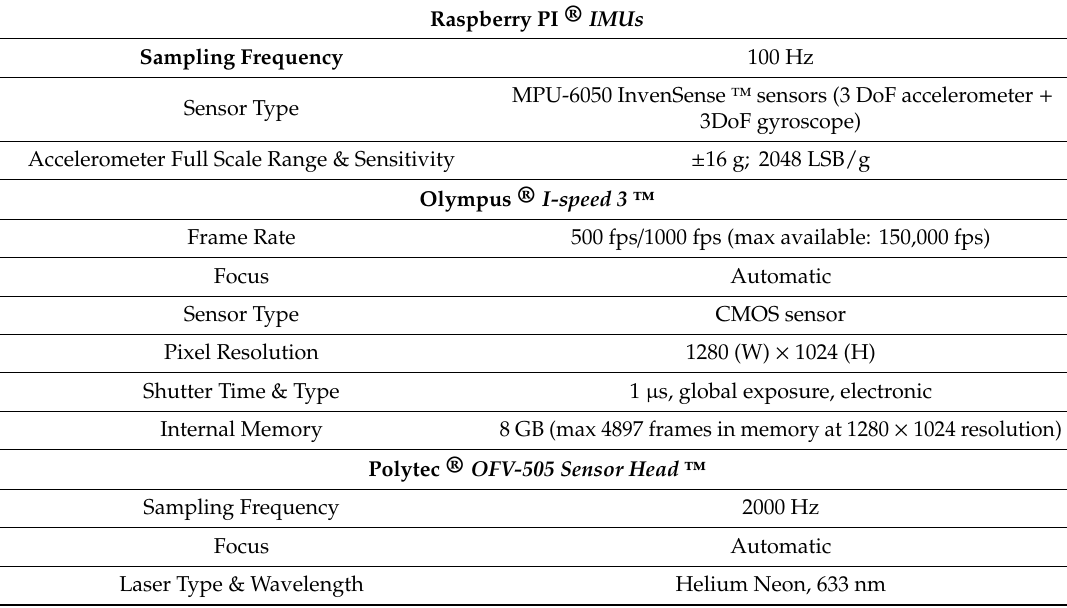
Table 2. Technical details of the instrumentation and parameters set.